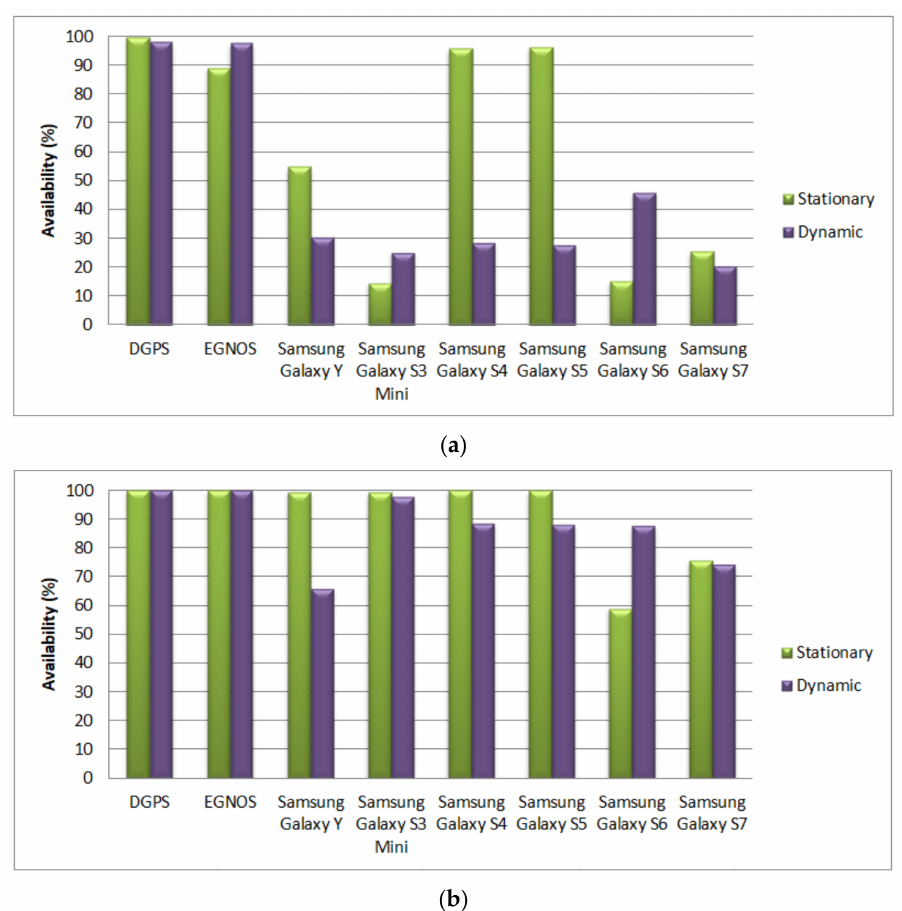
Figure 7. The availability of the DGPS and EGNOS systems, as well as multi-GNSS receivers, for the IHO special order ( a ) and for the order 1a / 1b ( b